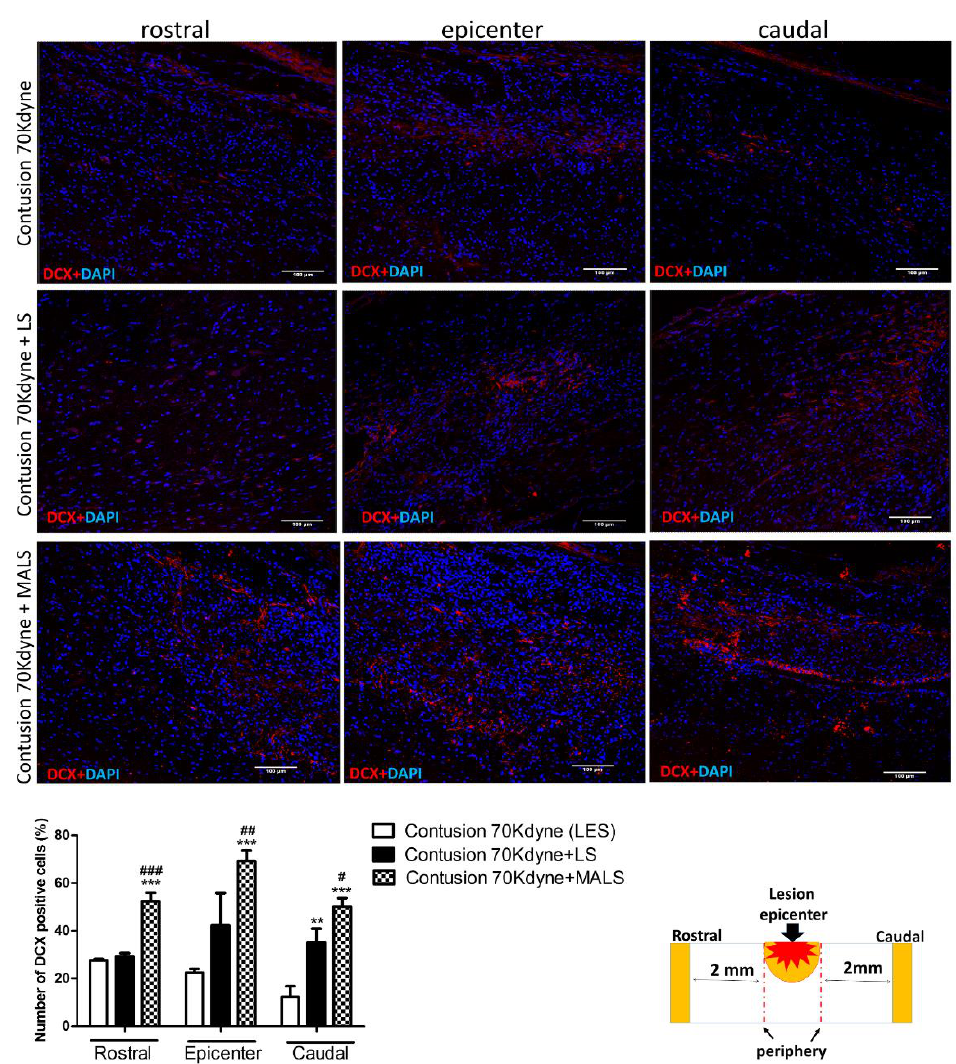
Figure 6. MALS tissue promotes re-growth of neurons. Spinal cord longitudinal sections were examined for DCX (red) expression 35 days after MALS transplant. Scale bar: 100 µ m. The graph shows the quantification of positive cells (percentage) in sections taken at the lesion epicenter, 2 mm rostral or caudal to the lesion epicenter (please see schematic representation). Values represent mean ± SD. We determined the statistical di ff erences by means of one-way ANOVA test followed by Bonferroni’s post-test. ** p < 0.01, *** p < 0.001 vs. LES, # p < 0.05, ## p < 0.01, ### p < 0.001 vs. LS. (n = 4 mice; 2 sections / mouse; 3 fields / section